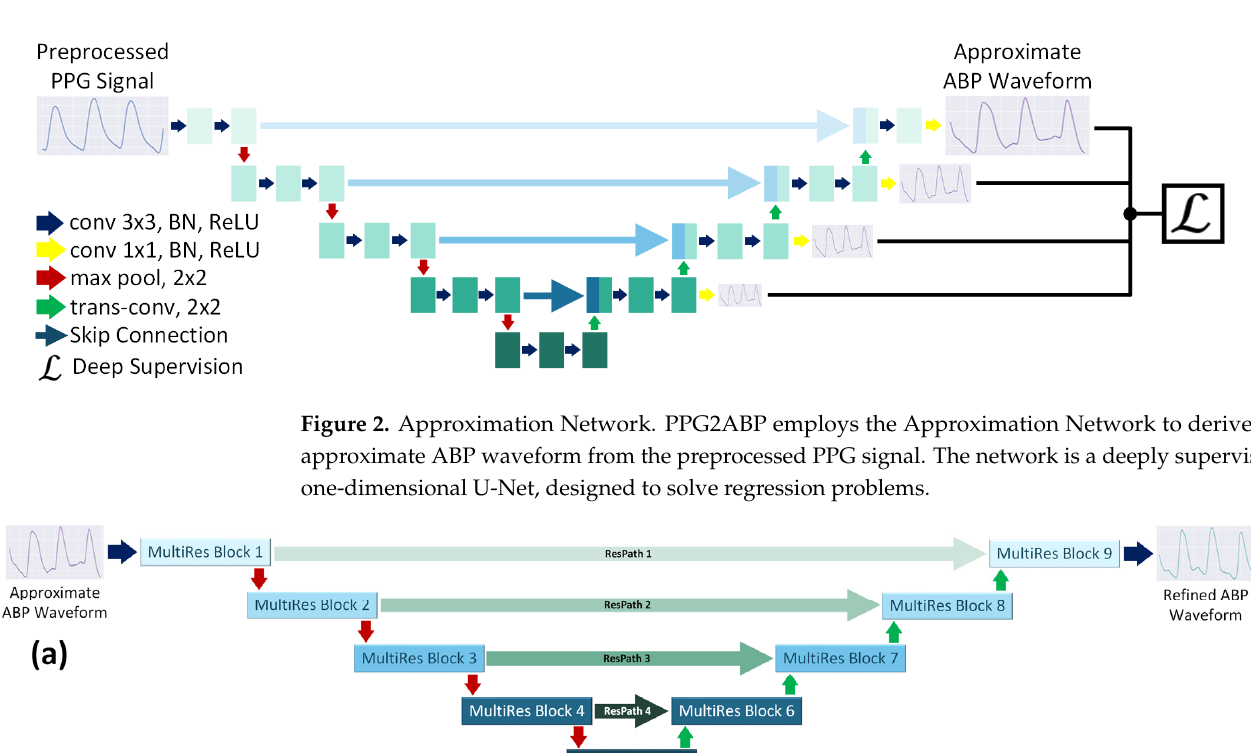
Figure 2. Approximation Network. PPG2ABP employs the Approximation Network to derive an approximate ABP waveform from the preprocessed PPG signal. The network is a deeply supervised one-dimensional U-Net, designed to solve regression problems.